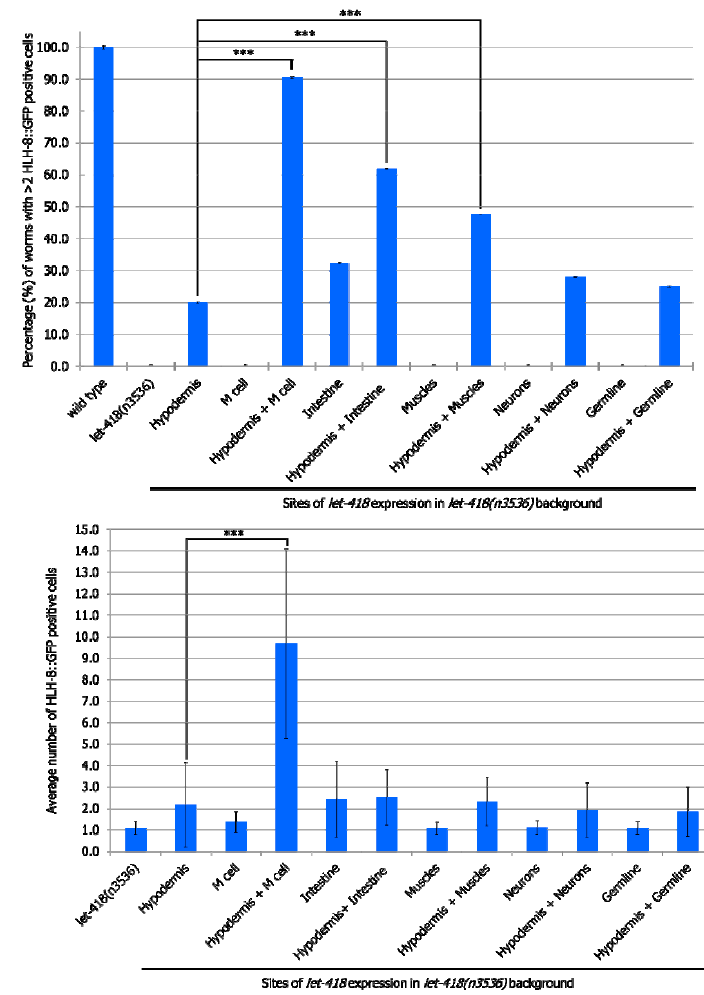
Figure 5. LET-418/Mi-2 acts cell autonomously in M mesoblasts for further development. ( A , C ) Percentage of worms with at least 3 M derived cells after 30 hrs after birth. Error bars indicate standard deviation. *** p < 0.001; Fisher’s test. ( B , D ) The average number of phlh-8::gfp positive cells in let-418 mutants with LET-418/Mi-2 activity in the intestine or hypodermis combined with any of the other tissues. The average number was recorded at 30 h after birth. For clarity purposes the highest average number of M-cell descendants in wild type animals (18.7 ± 0.9) is not displayed on this graph. Error bars indicate standard deviation. *** p < 0.001; unpaired t